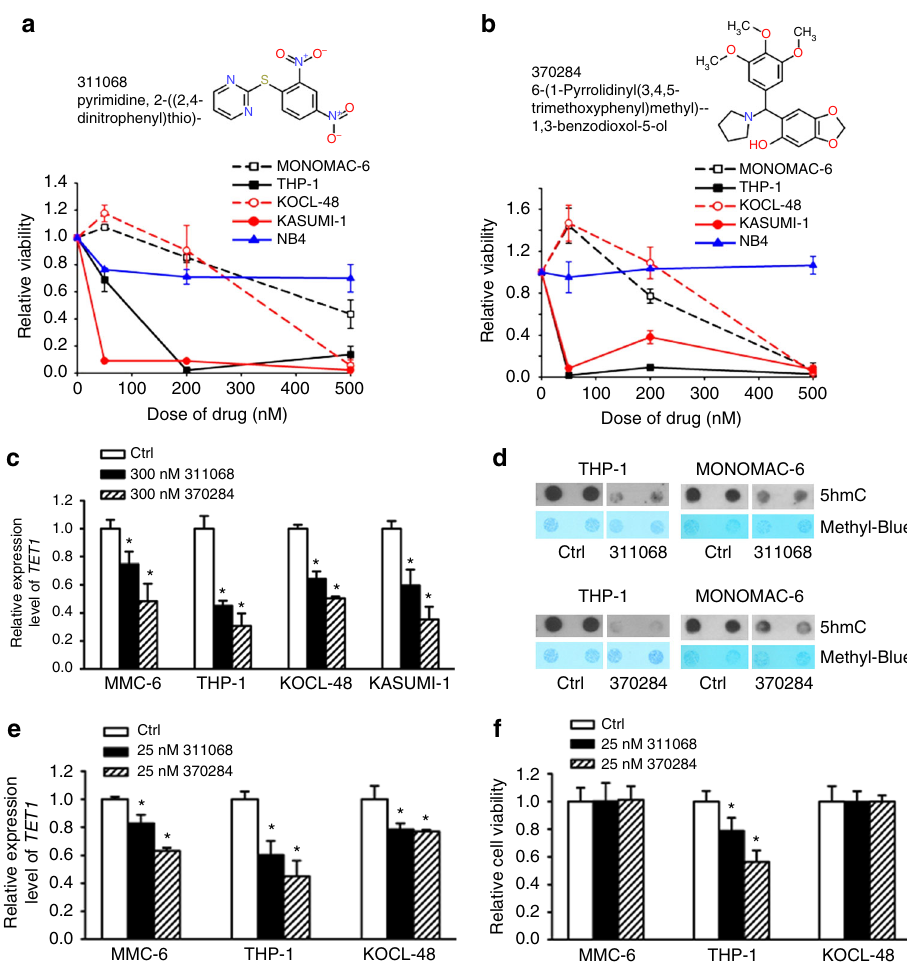
Fig. 1 NSC-311068 and NSC-370284 suppress the viability of AML cells with high TET1 level. a , b TET1 -high AML cell lines including MONOMAC-6, THP-1, KOCL-48, and KASUMI-1, along with a TET1 -low control cell line (i.e., NB4), were treated with NSC-311068 ( a ), or NSC-370284 ( b ), at indicated doses (0, 50, 200, 500 nM). Cell viability was analyzed by MTS 48 h post treatment. c Repression of TET1 expression by NSC-311068 and NSC-370284 in AML cell lines. Cells were treated with DMSO, or 300 nM NSC-311068 or NSC-370284. TET1 expression levels were detected by qPCR 48 h post treatment. d NSC- 311068 and NSC-370284 (both at 300 nM) repressed global 5hmC level in THP-1 (left panels) and MONOMAC-6 (right panels) cells. e , f MONOMAC-6, THP-1, and KOCL-48 cells were treated with DMSO, or 25 nM NSC-311068 or NSC-370284. TET1 expression levels ( e ), and cell viability ( f ), were